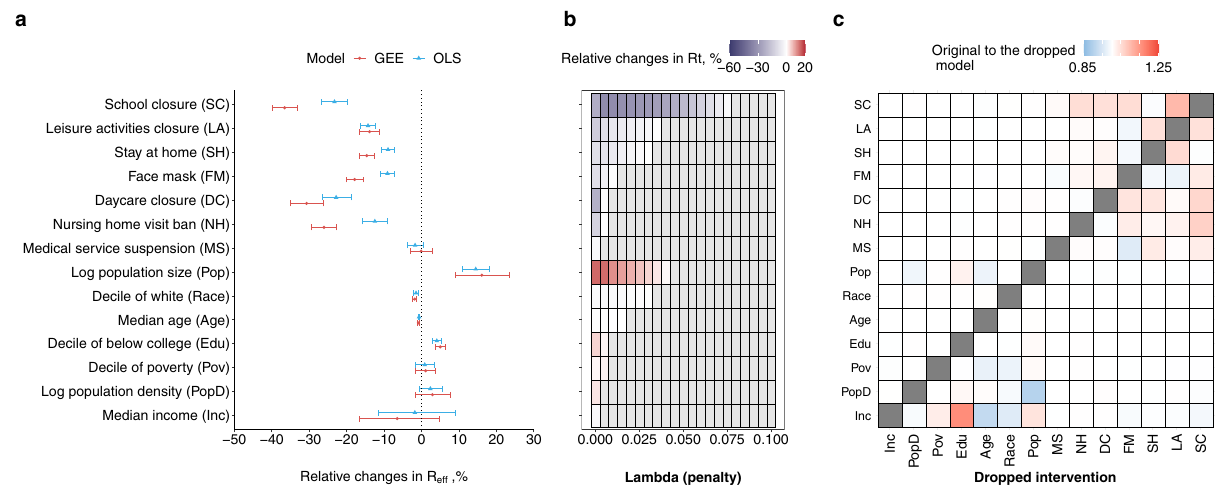
Fig. 3 Associations between non-pharmaceutical interventions (NPIs) and county-level characteristics on transmission. a Associations between NPIs and county-level characteristics estimated from the main model ( n = 31,072 county-weeks). Models were fi tted with both generalized estimating equations (GEEs, red) and ordinary least squares (OLS, blue) models. Data are presented as mean and 95% con fi dence interval. The order in y -axis (same for c ) is according to the importance of covariates in explaining the variances shown in b . b The importance of covariates in explaining the variances. Main models that were formulated for OLS models and fi tted to least absolute shrinkage and selection operator (LASSO) with increasing parsimony. c Changes in the estimated effects when each covariate is dropped in the main OLS model.